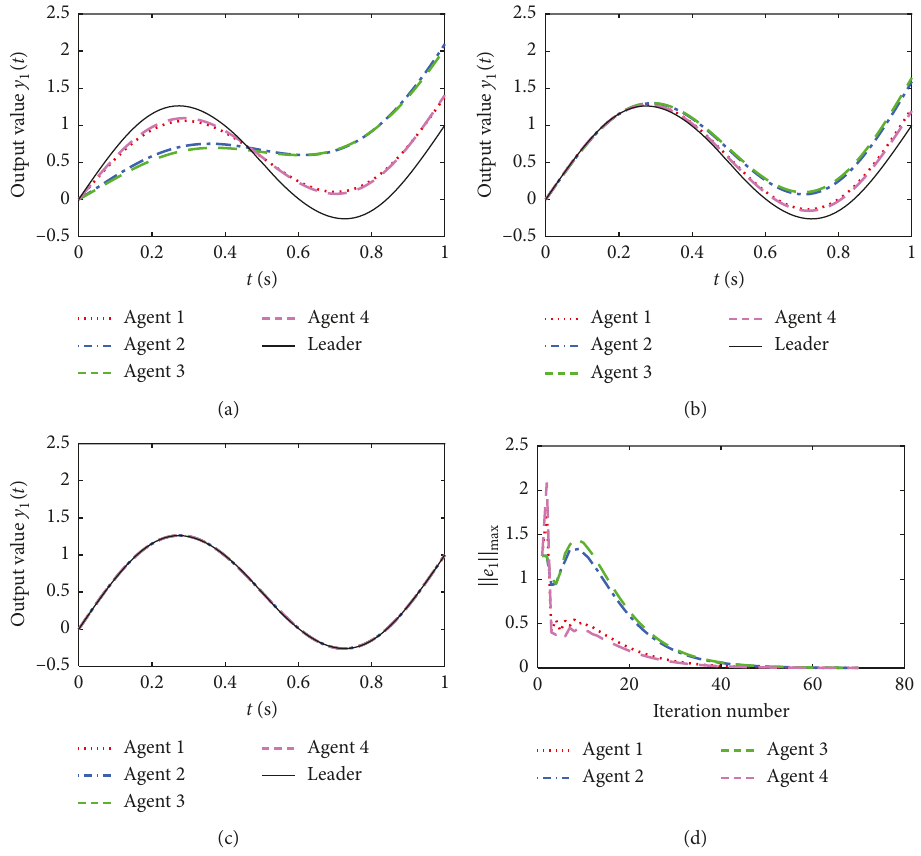
Figure 2: Results of y PD α -type FOILC. (a) Trajectories y 1 with open-loop 1 ( t ) at the 5th iteration. (b) Trajectories y 1 ( t ) at the 20th iteration. (c) Trajectories y 1 ( t ) at the 70th iteration. (d) Tracking error e 1 vs. iteration